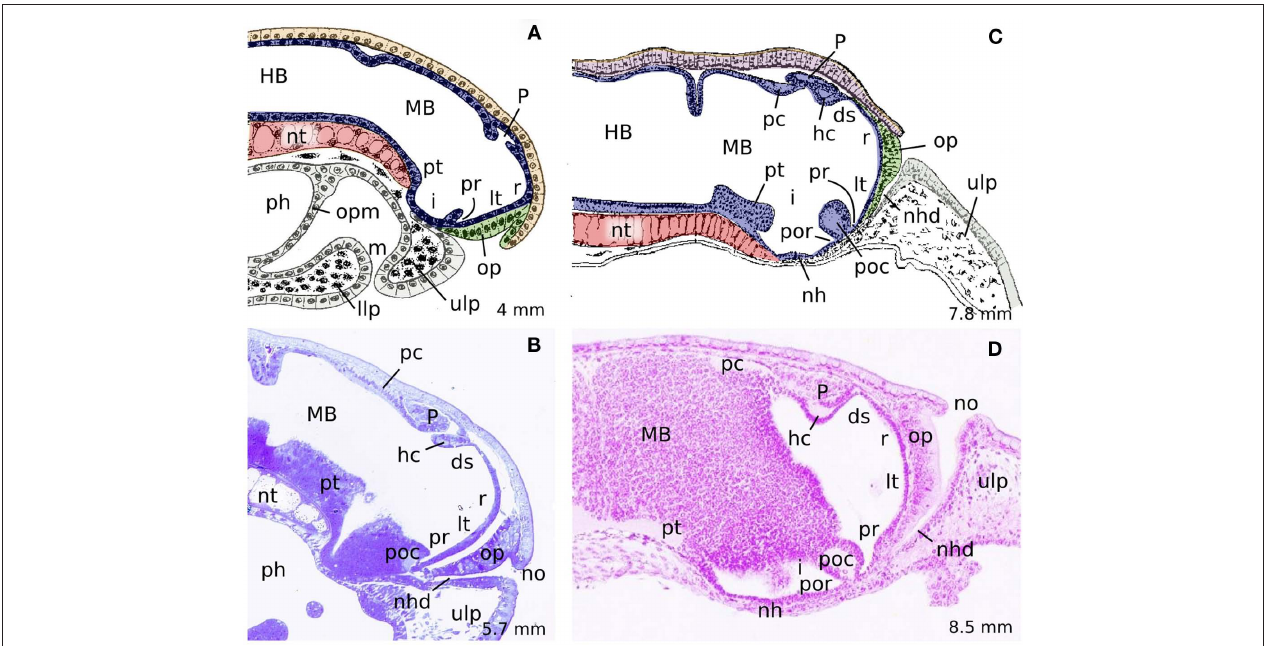
right. ds, dorsal sac; HB, hindbrain; hc, habenular commissure; i, infundibulum; llp, lower lip; lt, lamina terminalis; m, mouth; MB, midbrain; nh, neurohypophysis; nhd, nasohypophyseal duct; no, nasal opening; nt, notochord; op, olfactory placode; opm, oropharyngeal membrane; P, pineal organ; pc, posterior commissure; ph, pharynx; poc, postoptic commissure; por, postoptic recess; pr, preoptic recess; pt, posterior tuberculum; r, neuroporic recess; ulp,